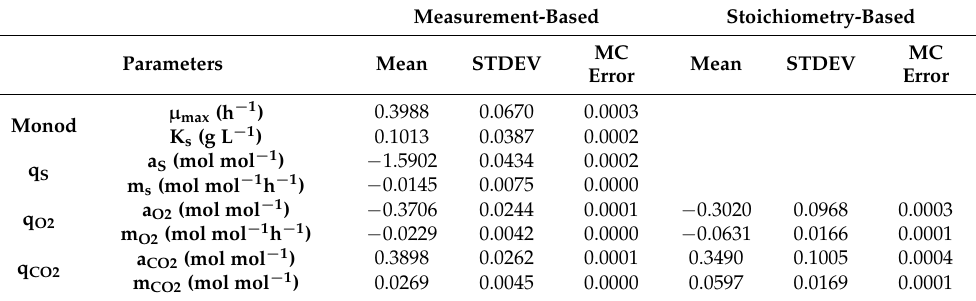
Table 3. Parameter estimation of measured values of wild-type Y. lipolytica W29. The average, standard deviation, and Monte Carlo (MC) error of the estimated parameters are reported in the table below. Measurement-Based Stoichiometry-Based